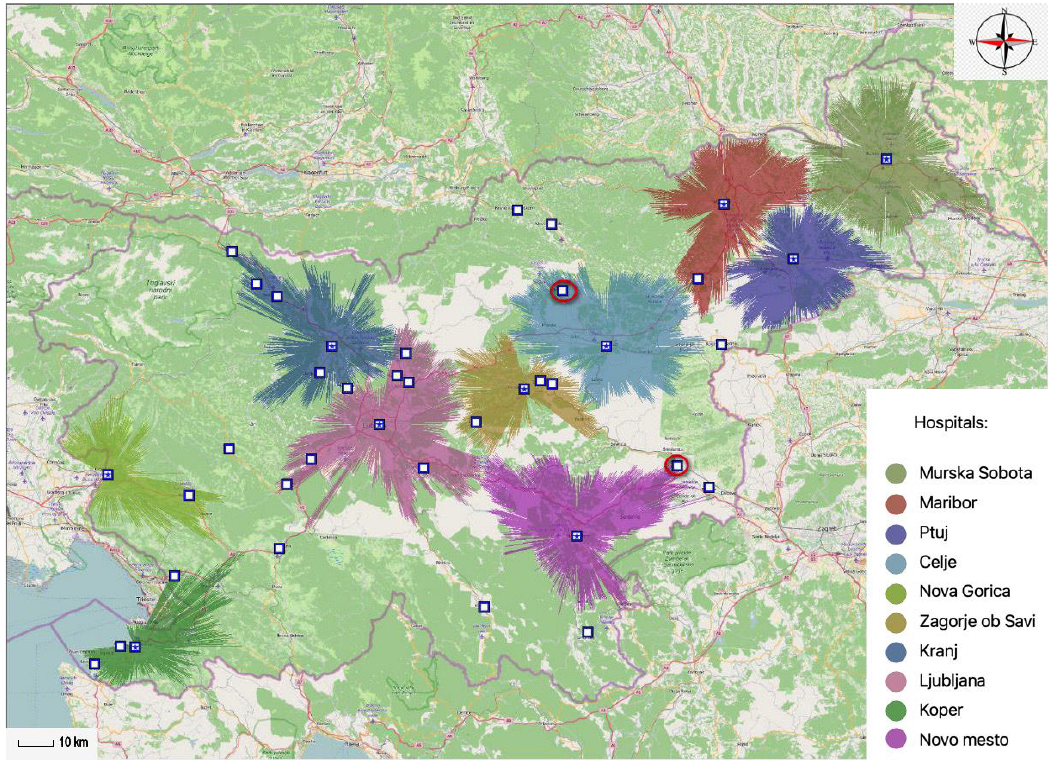
Figure 5. Optimal locations of ten different general hospitals within the 30-min time interval.